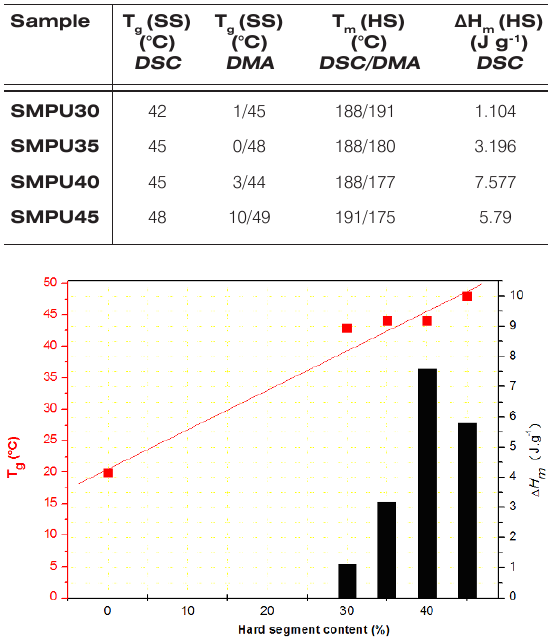
Table 2. Thermal analysis data.